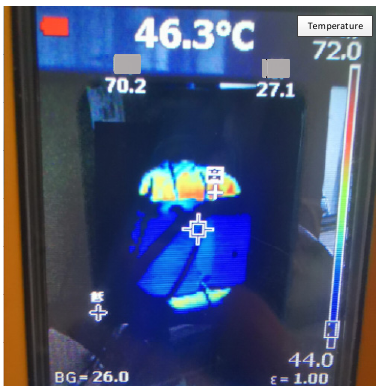
Figure 12. Experimental temperature distributions of the studied reactor under the thermal steady-state condition when voltage is ±1050 V.